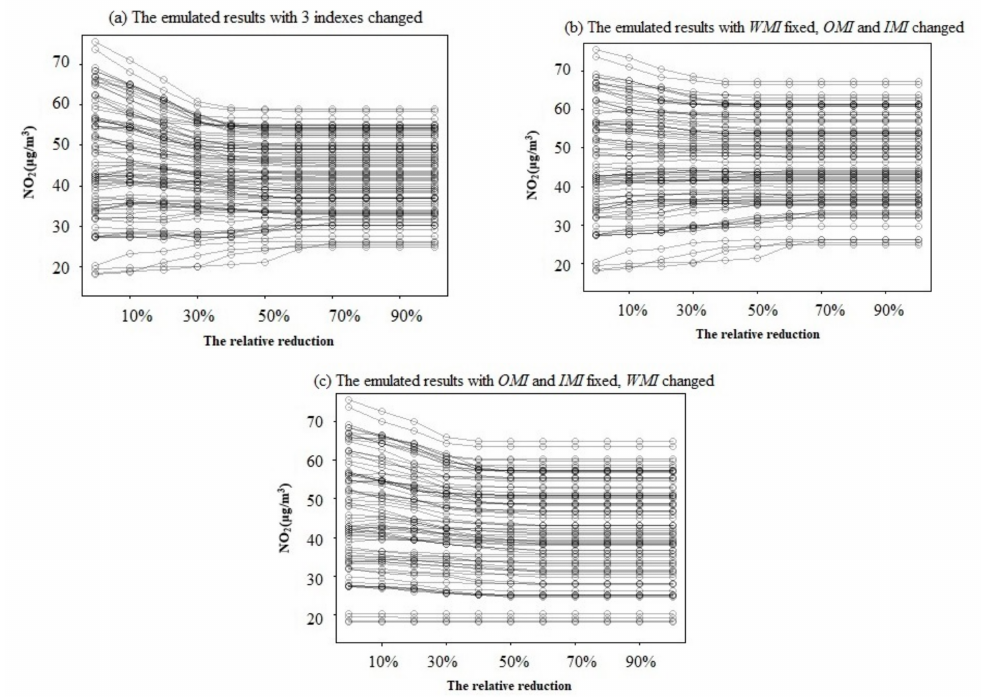
Figure 6. The simulated results of the decreased road traffic and the NO 2 concentration: ( a ) 3 indexes changed; ( b ) WMI fixed, OMI and IMI changed; ( c ) OMI and IMI fixed, WMI